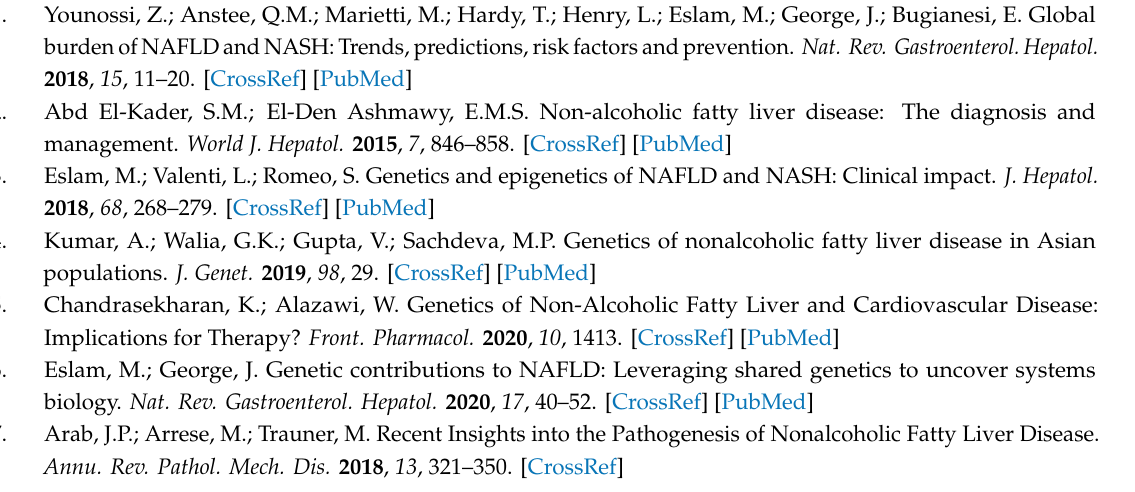
Figure S1: Dynamics of NAFLD core regulatory network, Figure S2: Frequency and characterization of HL and LH states, Figure S3: Relative stability for multistable phases, Figure S4: Kernel density estimate plots, Figure S5: Clinical data estimates, Figure S6: Robustness of methods